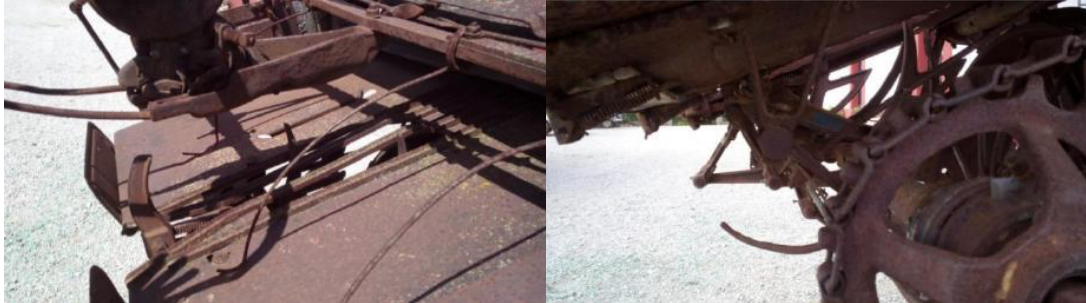
Figure 21. System of knotting and compacting needles: top view ( left ) and bottom view ( right ).